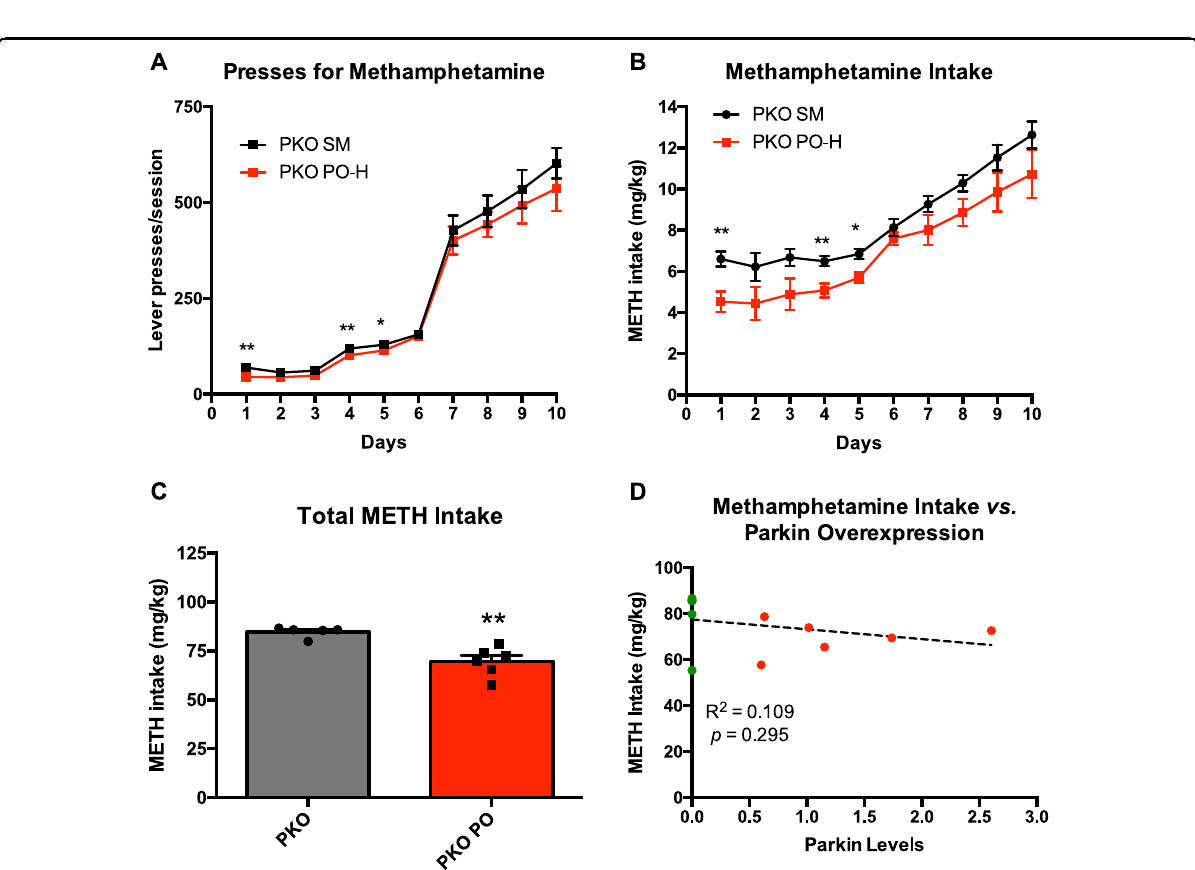
Fig. 6 The effect of PARKIN overexpression in the nucleus accumbens of Parkin gene knockout (PKO) rats. High PARKIN overexpression (15 – 20-fold) in the nucleus accumbens of Parkin knockout PKO rats signi fi cantly attenuated methamphetamine (METH) taking in the fi rst half of the extended-access METH self-administration as compared to non-overexpressing PKO rats. A Lever presses for METH, B METH intake. C Total amount of METH consumed by PKO PO rats was signi fi cantly lower than the total amount of METH consumed by PKO rats ( − 18%). D Correlation analysis of total METH intake with PARKIN levels in PKO PO group (red dots: PKO PO group; green dots: PKO group). * p < 0.05, ** p < 0.01, n = 5 or 6/group. Data are expressed as mean ±